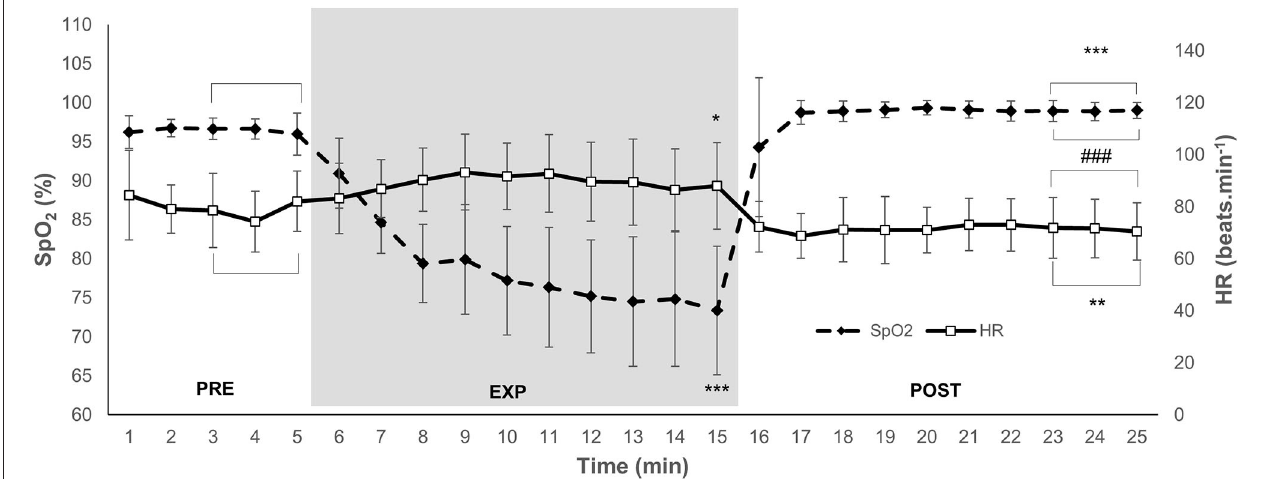
FIGURE 1 | Mean and SD arterial oxygen saturation (SpO 2 ) and heart rate (HR) during 5min normoxic breathing (PRE), 10min hypoxic breathing of 10% O 2 (EXP), and 10min hyperoxic breathing of 100% O 2 (POST) for n = 15. Gray zone indicates EXP. Horizontal brackets indicate an averaged value for that period. Significant difference from (PRE) is indicated by * for P < 0.05, ** for P < 0.01, and *** for P < 0.001. Significant difference from EXP is indicated by ### for P <